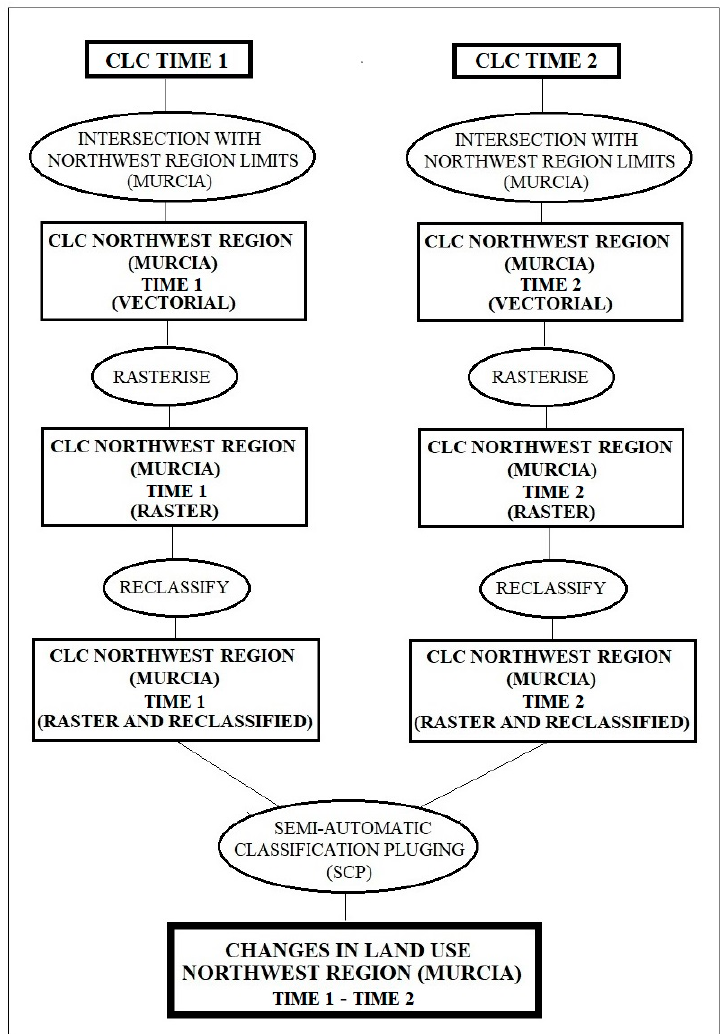
Figure 1. Methodology for the treatment of spatial data (flow diagram). Source: Authors.